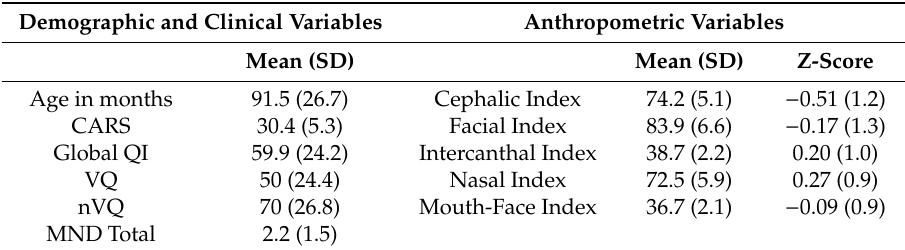
Table 1. Demographic, clinical and anthropometric characteristics of the 33 children with ASD.